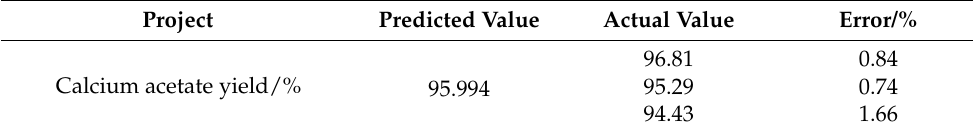
Table 4. Comparison of predicted value and actual values under optimal conditions.